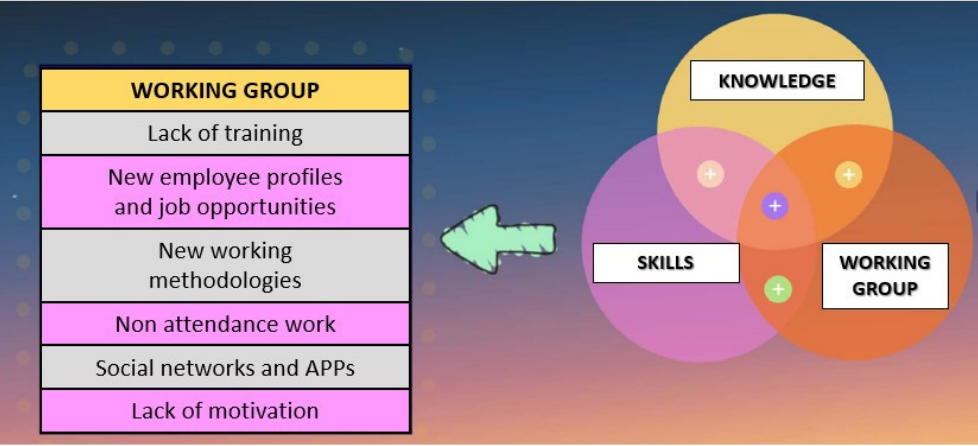
Figure 4. Example of indicator selection in the working group. Source: own elaboration.